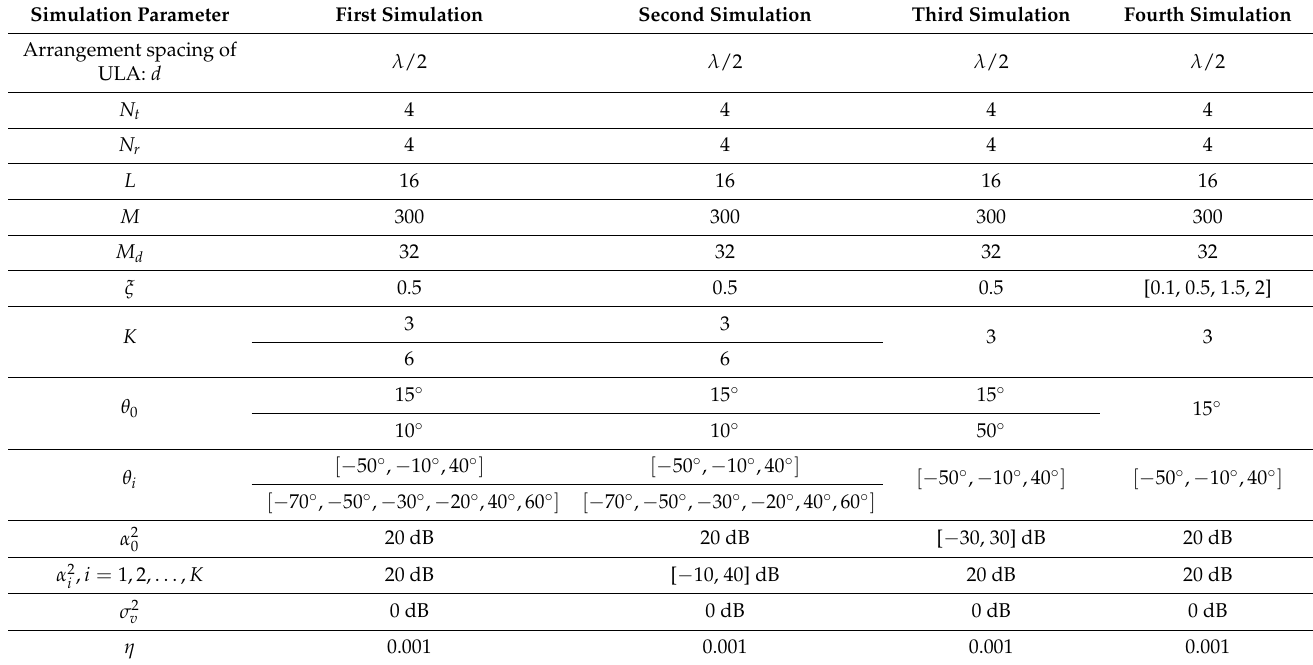
Table 1. System simulation